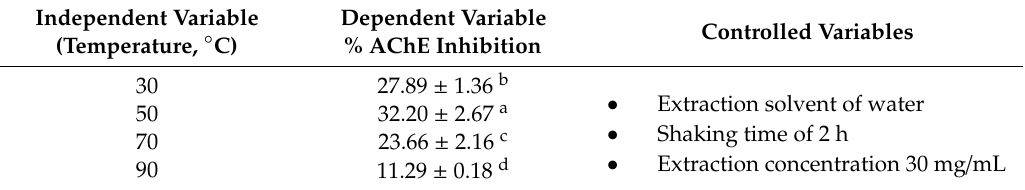
Table 3. E ff ect of di ff erent temperatures on MNCM extraction regarding AChE